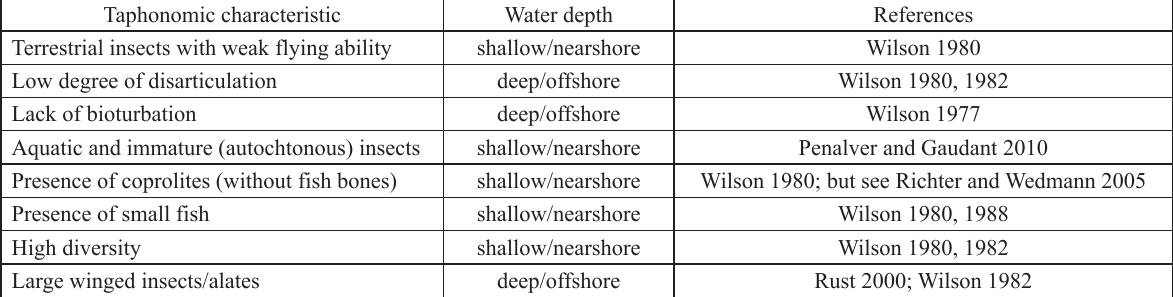
Table 1. Factors that may define the depositional environment of insects preserved as fossils in lacustrine-derived shale. Taphonomic